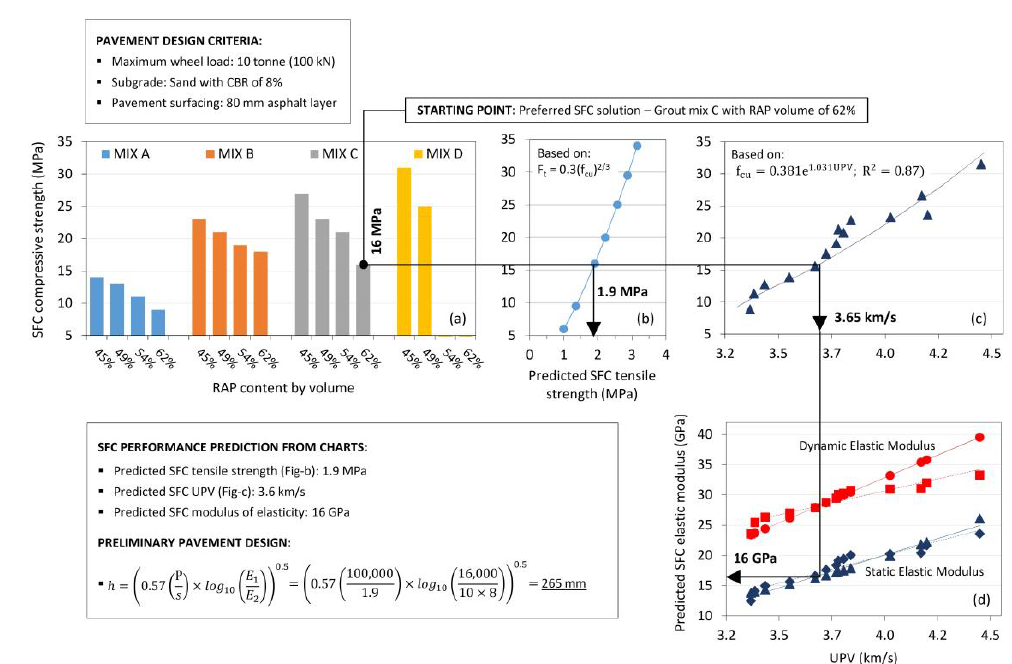
Figure 6. Mix design example for SFC utilised as a sub-base layer in a heavy-duty pavement application including: ( a ) laboratory-based compressive strength data; ( b ) predicted tensile strength values; ( c ) laboratory-based UPV data; and ( d ) predicted elastic modulus values.